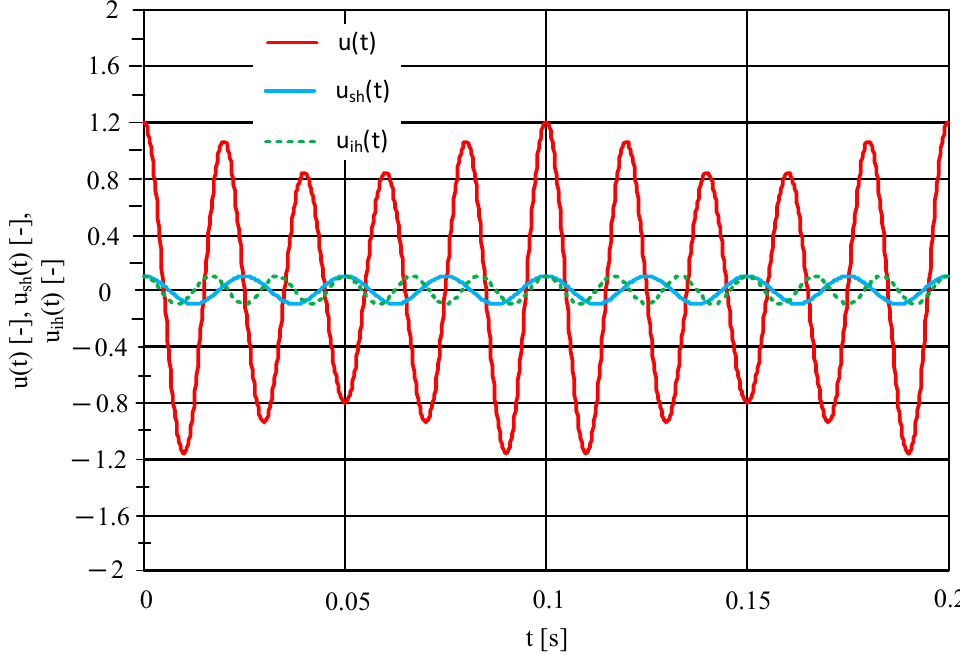
Figure 1. Subharmonic and interharmonic components and their superposition with the fundamental component for a = 0.1, f sh = 40 Hz, f ih = 60 Hz and ϕ sh = 0°, ϕ ih = 0° (amplitude modulation).